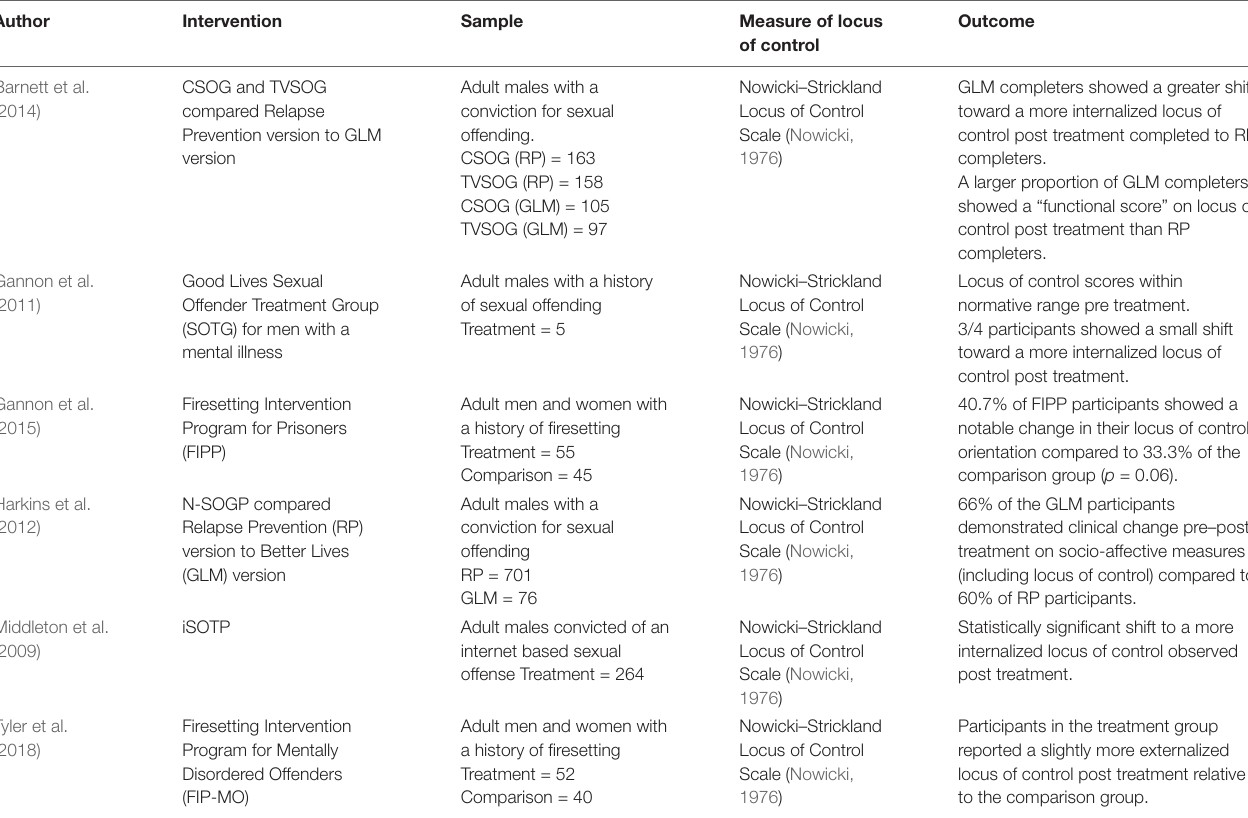
TABLE 2 | Summary of studies examining outcomes for GLM-informed interventions on locus of control